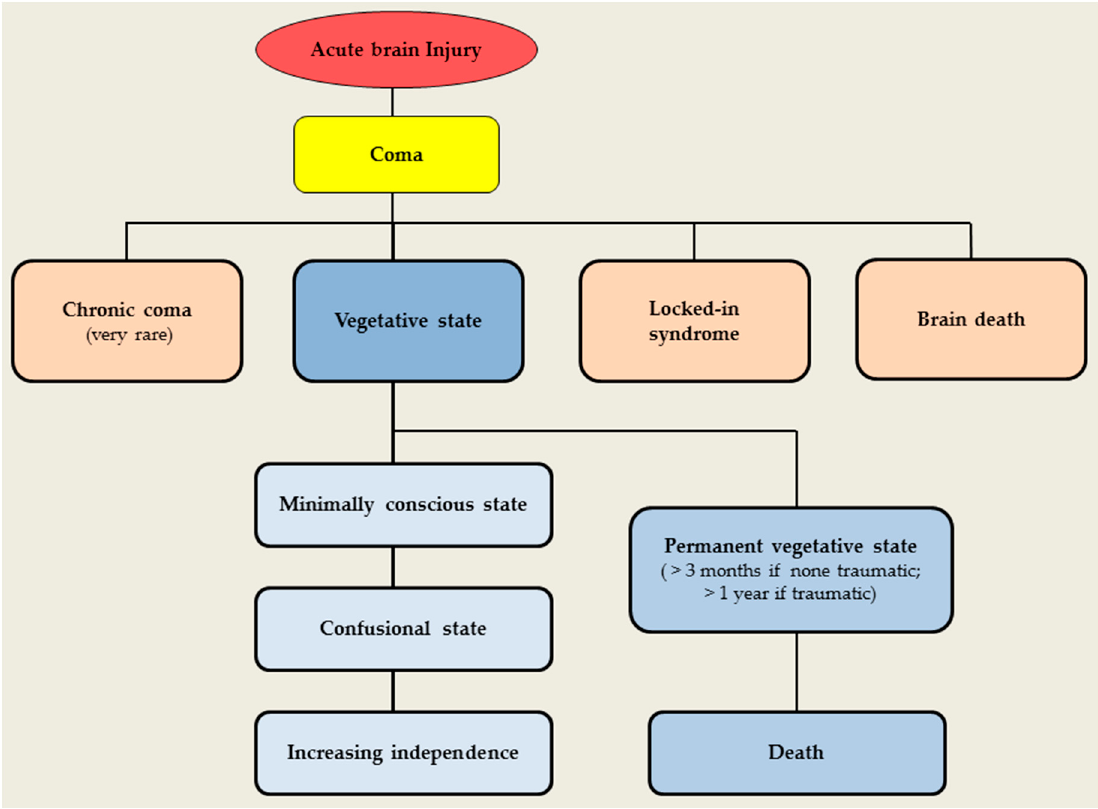
Figure 1. The Flowchart of cerebral insult, coma, vegetative state, brain death, and related disorders